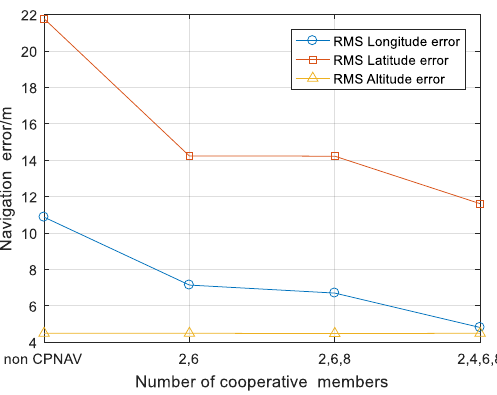
Figure 14. RMS error comparison between estimates with different numbers of cooperative members.